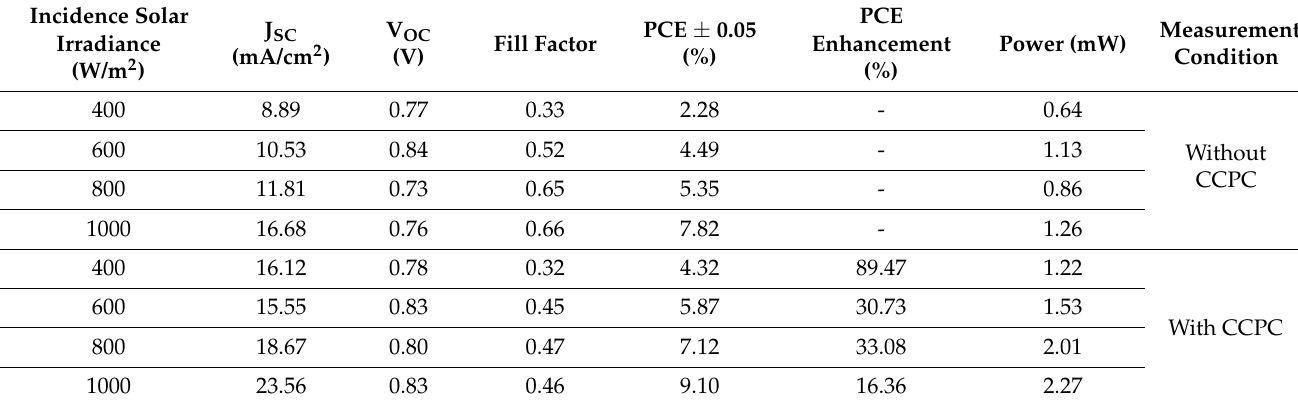
Table 1. Photovoltaic performance of carbon-based perovskite solar cells, with and without CCPC, over an active area of 1 cm 2 . Incidence Solar